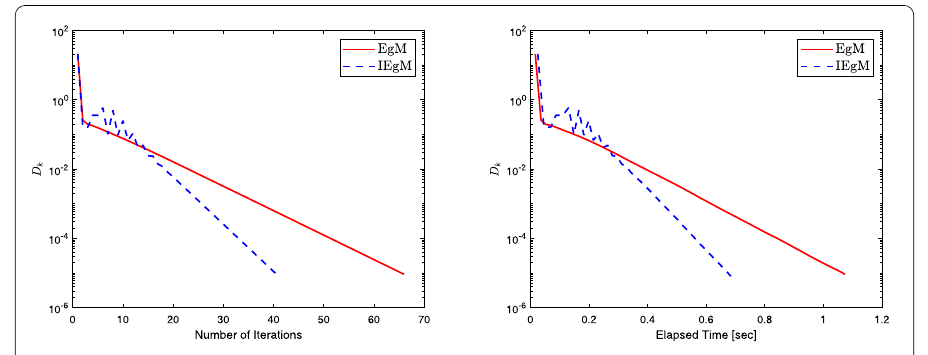
Figure 11 Computational comparability of Algorithm 2 with Algorithm 3.1 in [36] for M = 50